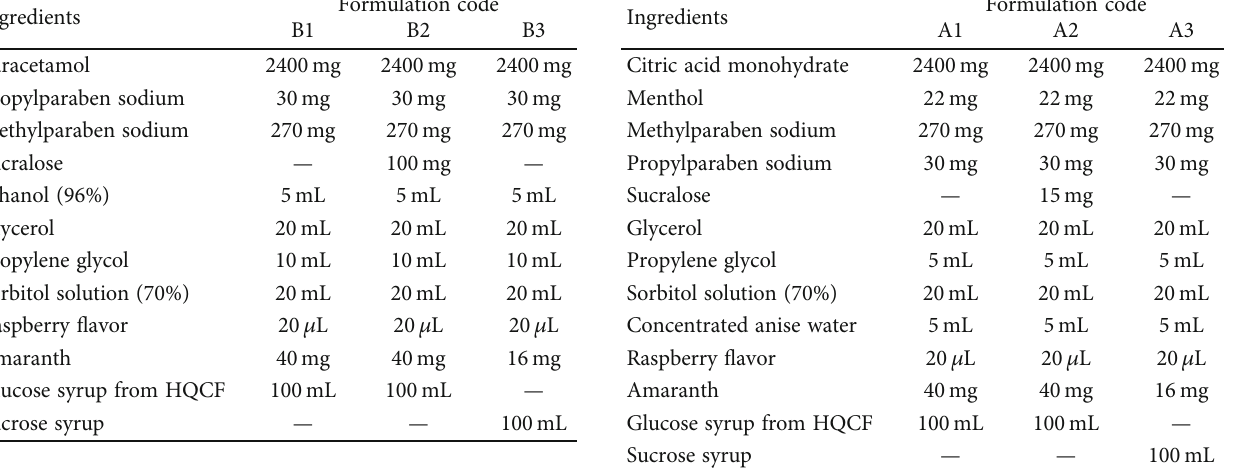
Table 1: Composition of formulated paracetamol syrup BP. Ingredients